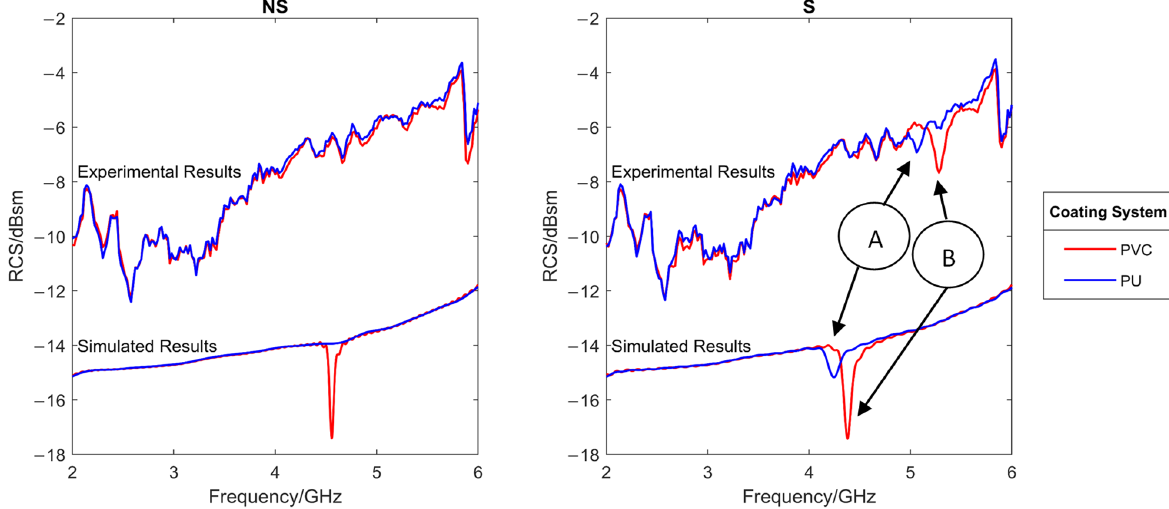
Figure 16. Comparison of the simulated and measured RCS response of sensors mounted directly on coated system (NS, right ) and sensors mounted on an additional substrate (S, left ). Identifiable peaks are matched between simulated and experimental results with designators A and B.